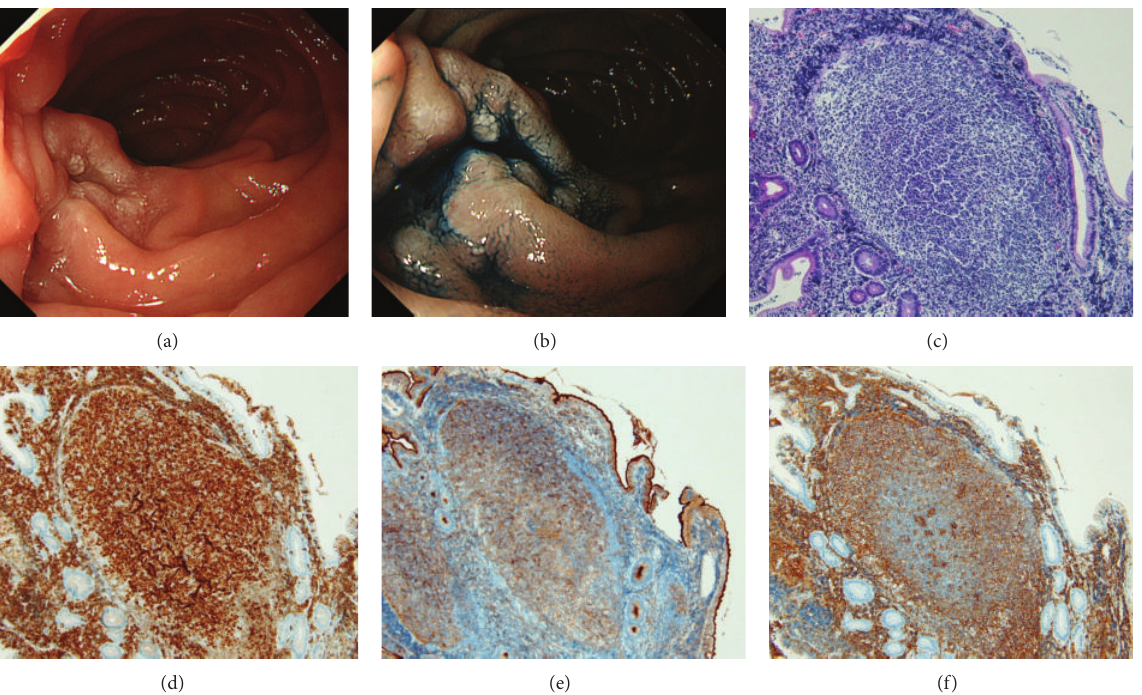
Figure 1: Esophagogastroduodenoscopy revealed whitish mucosa in the duodenum before (a) and after spraying indigo carmine dye (b). Biopsy specimens contained small- to medium-sized lymphoma cells forming lymphoid follicles ((c), hematoxylin and eosin stain). Those cells were positive for CD20 (d), CD10 (e), and BCL2 (f) but negative for CD3. Consequently, the diagnosis of follicular lymphoma was